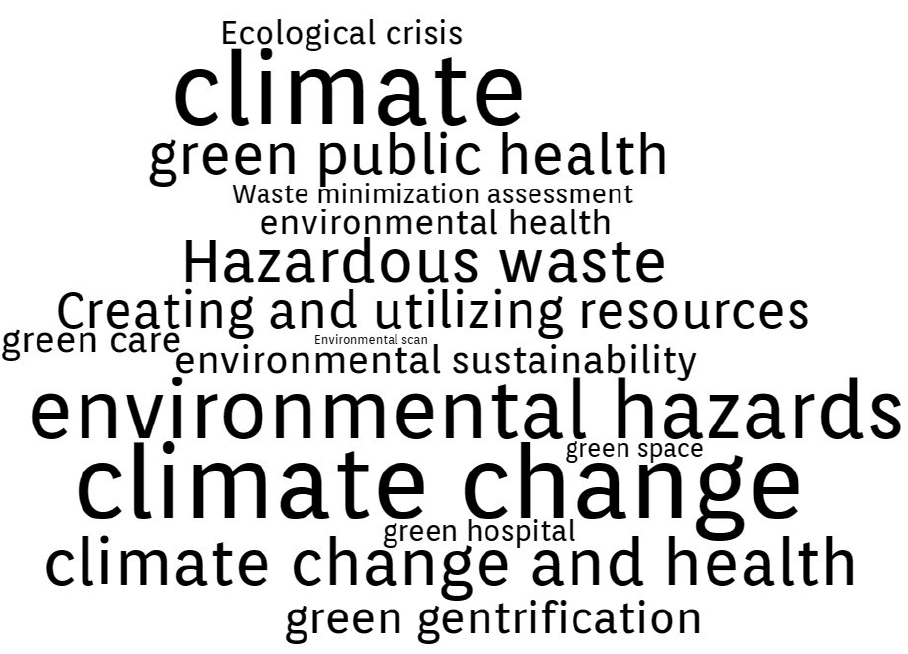
Figure 5. Climate cluster Authors’ Keywords.